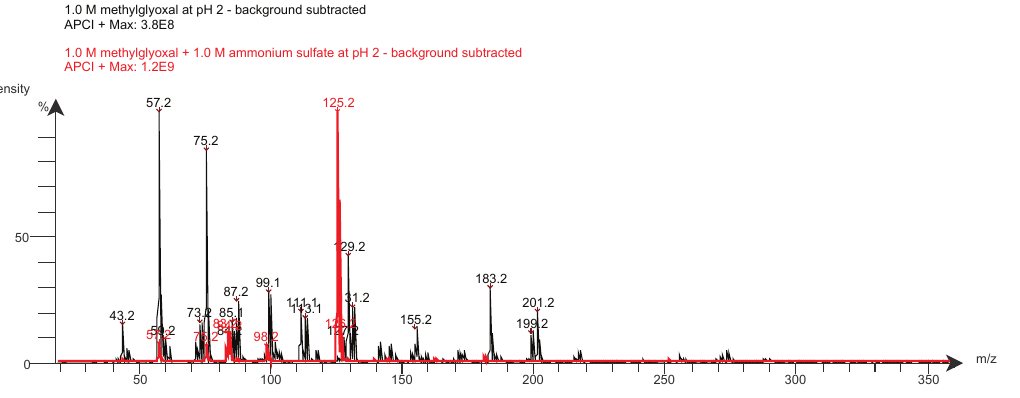
Figure 3. Atmospheric pressure chemical ionization (APCI) mass spectra for 1.0M methylglyoxal at pH2 (black) and the reaction with 1.0M ammonium sulfate after 10min (red). Intensity is set to 100% for the largest signal and does not correspond to concentration in the sample